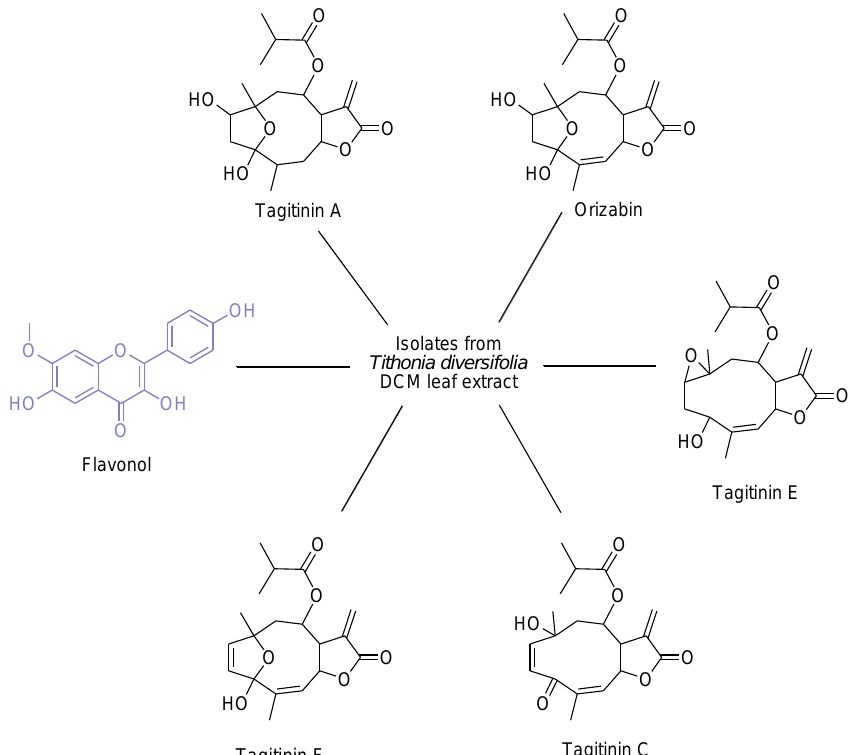
Figure 1. Compounds extracted from the antimalarial active TD DCM leaf fraction.